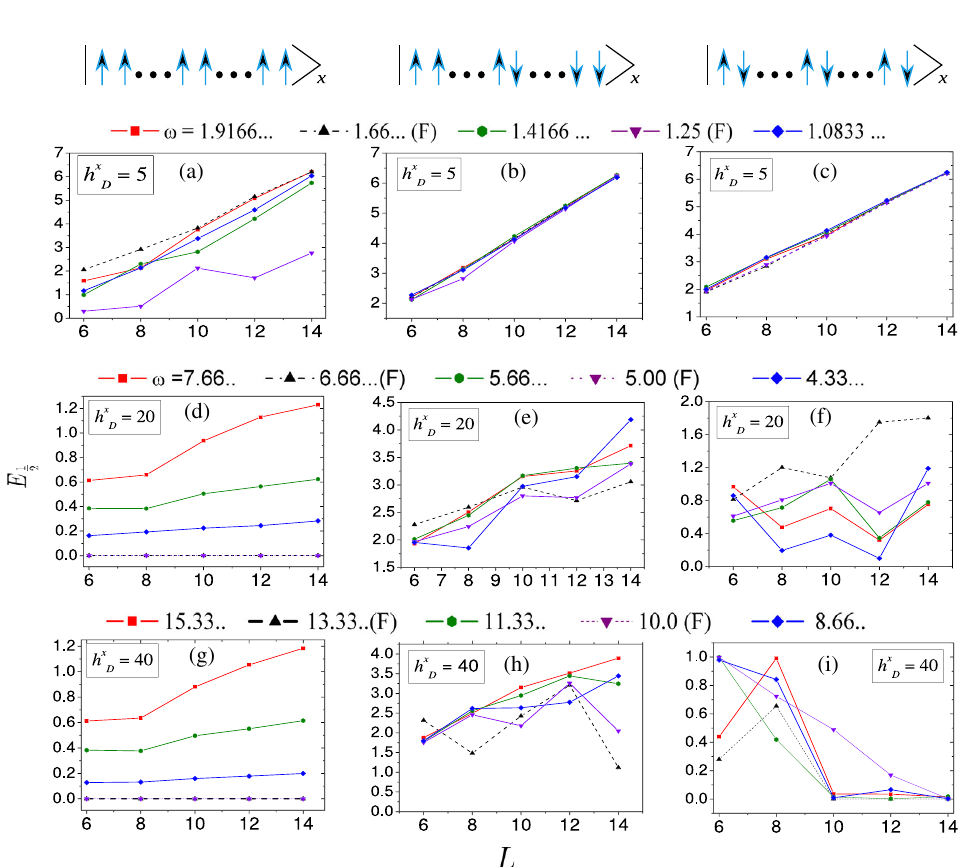
FIG. 2. (De)localization of the wave function over the x basis (simultaneous eigenstates of all of the σ x i ’ s) as evidenced by the half- chain entanglement entropy ( E 1 ) versus system size L , for different driving strengths h x D (rows) and initial states (left column: maximally 2 m x polarized; middle: L= 2 -domain-pair state with vanishing total m x ; right: N´eel state). Top row (small h x linearly with system size for all initial states, signaling ergodicity. For stronger drives ( h x D ¼ 20 and 40 in the middle and bottom rows, respectively), scars appear, and E 1 depends strongly on the initial states, reflecting the size of the emergent magnetization sectors: For the 2 does not grow at all for the freezing or scar points [marked as (F) in the figure legends fully polarized initial states (left column), E 1 2 and represented by almost indistinguishably coincidental black and violet triangles], while for the N´eel and the L= 2 -domain-pair initial states, there is considerable growth in E 1 even at the scar points, reflecting (at least partial) delocalization over the large concomitant 2 magnetization sectors. The results are for J ¼ 1 ; κ ¼ 0 . 7 ; h x 0 ¼ e= 10 ; h z ¼ 1 . 2 ; L ¼ 14 , averaged over 10 4 cycles after driving for 10 10